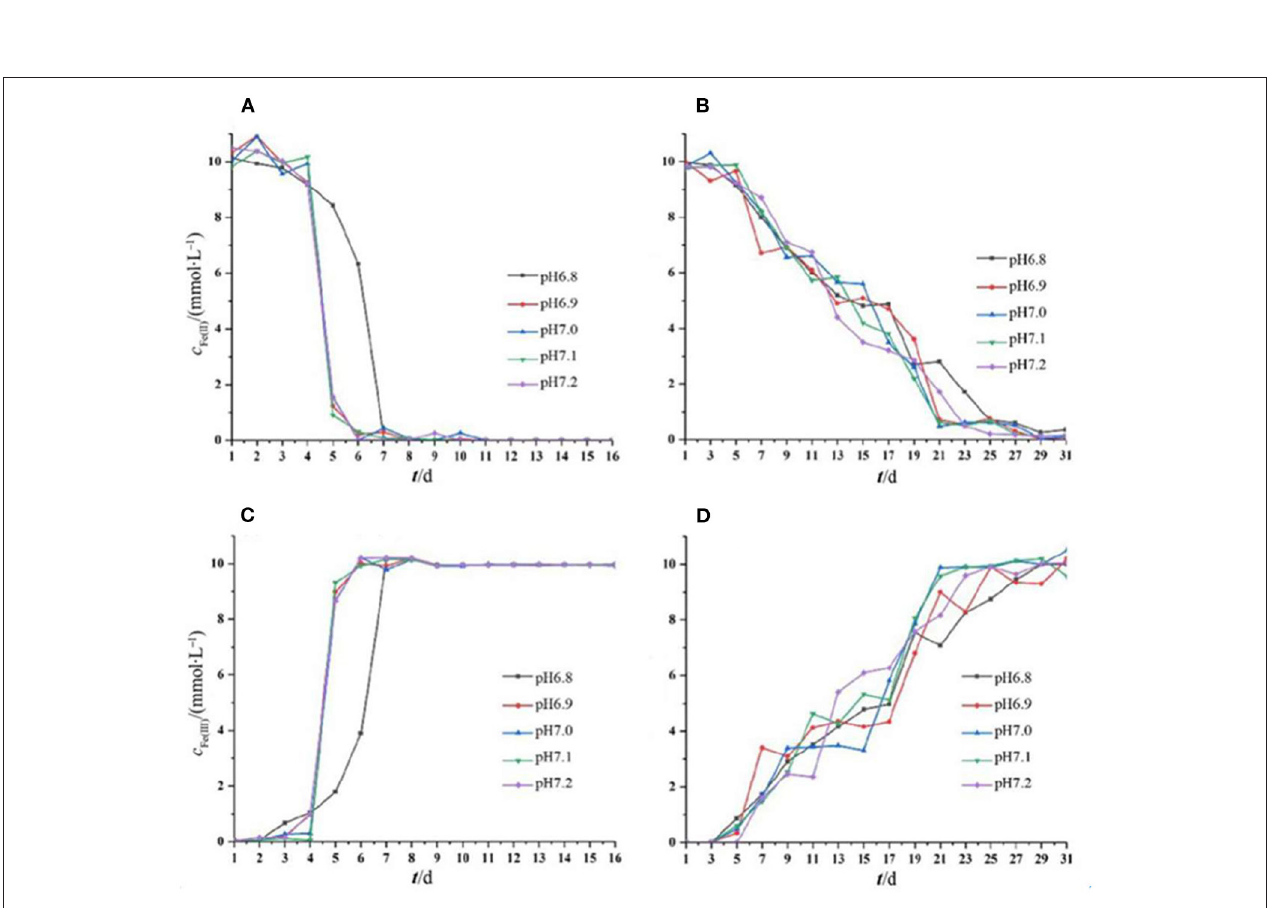
FIGURE 2 | Changes in Fe(II) and Fe(III) concentration throughout the period of cell growth under different pH pressures. Each experiment was run in triplicate cultures. Decreased Fe(II) concentration of strain BoFeN1 (A) and strain SW2 (B) , and increased Fe(III) concentration of strain BoFeN1 (C) and strain SW2 (D) .